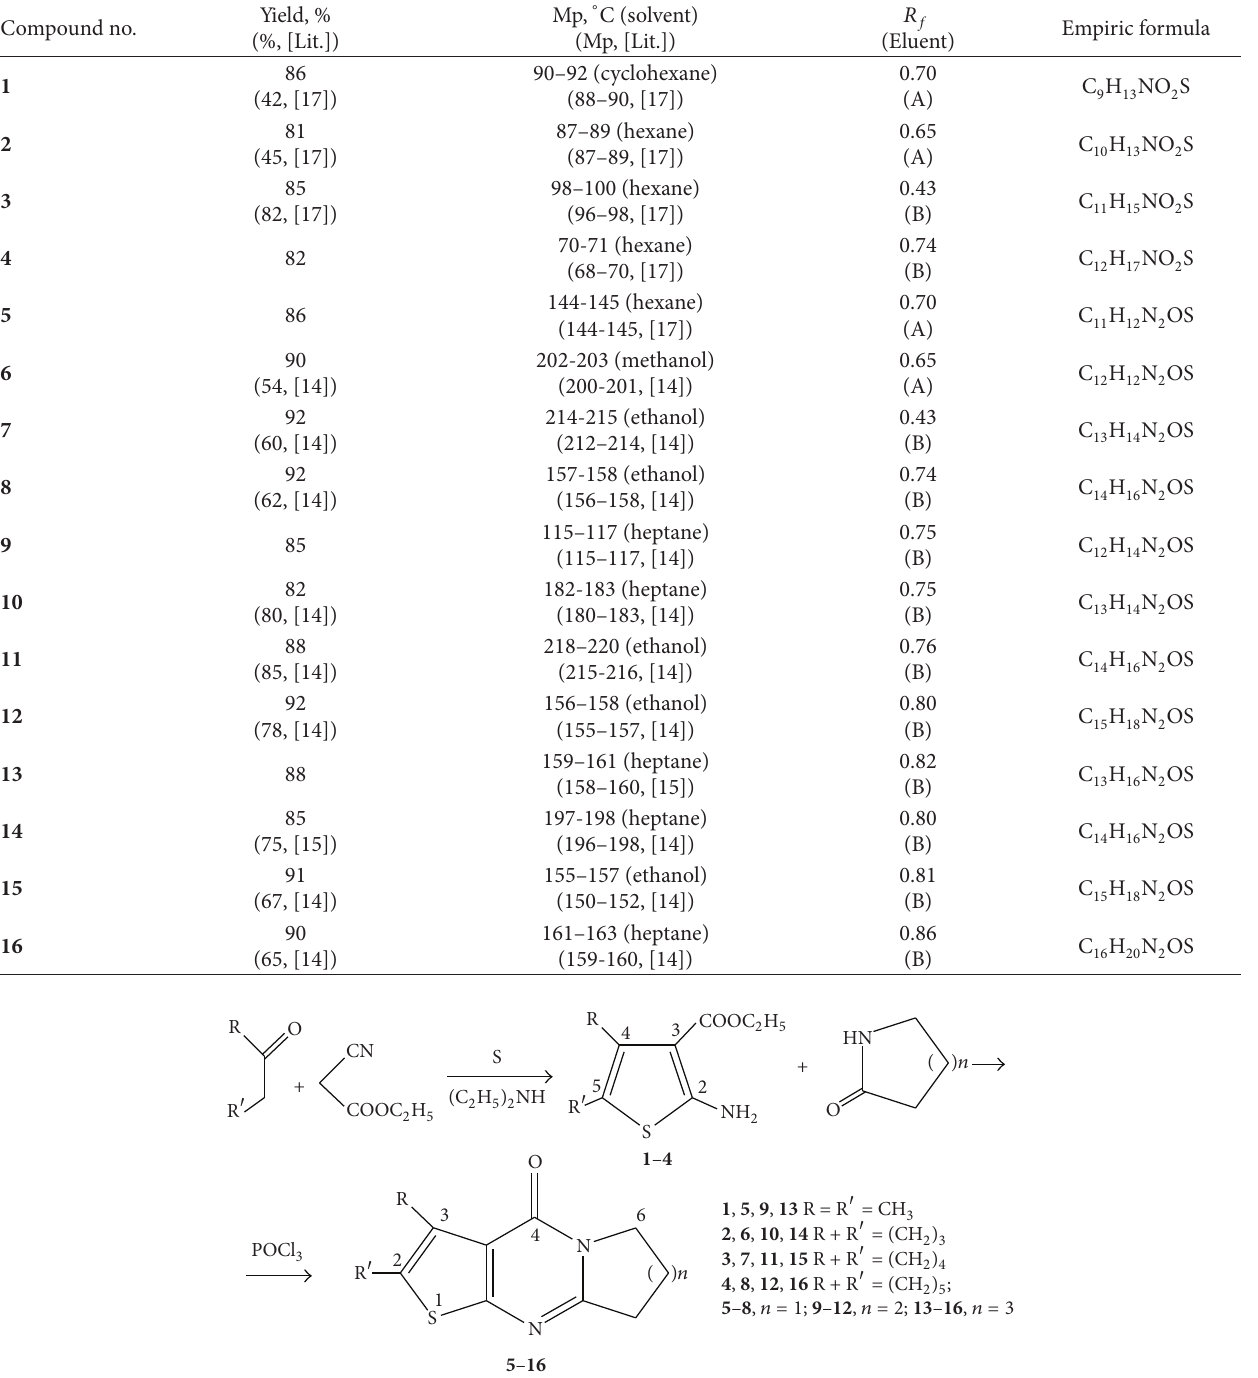
T 1: Some physical-chemical parameters of synthesized compounds (1–16)